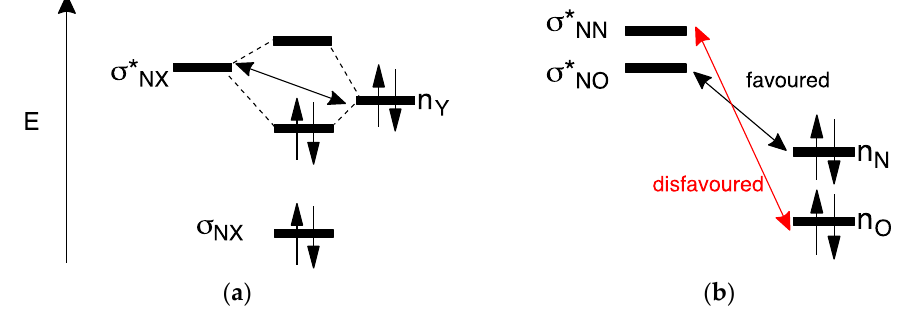
Figure 9. ( a ) Stabilisation of a lone pair through a n Y – σ * NX anomeric interaction and ( b ) the energetics